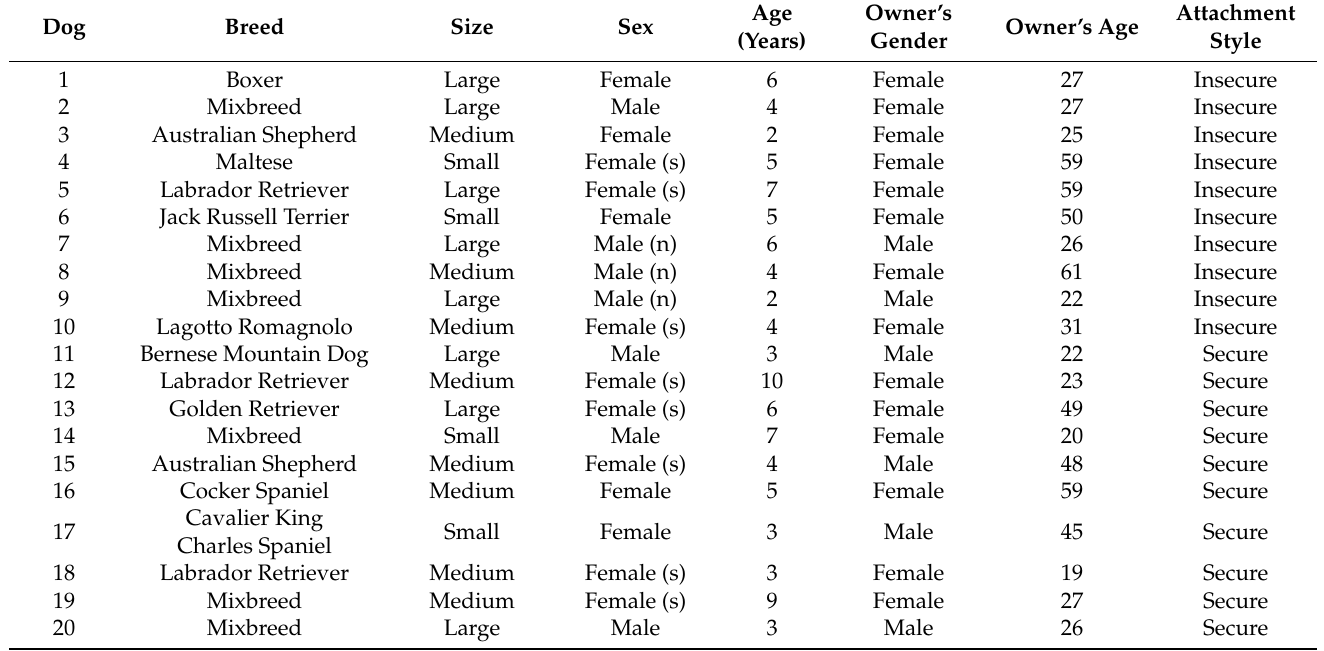
Table 1. Basic demographic characteristics of each dog-owner dyad and dog attachment